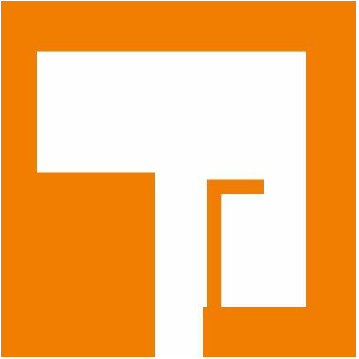
Figure 1. Evolution of single-port antenna for characteristic mode analysis (CMA).